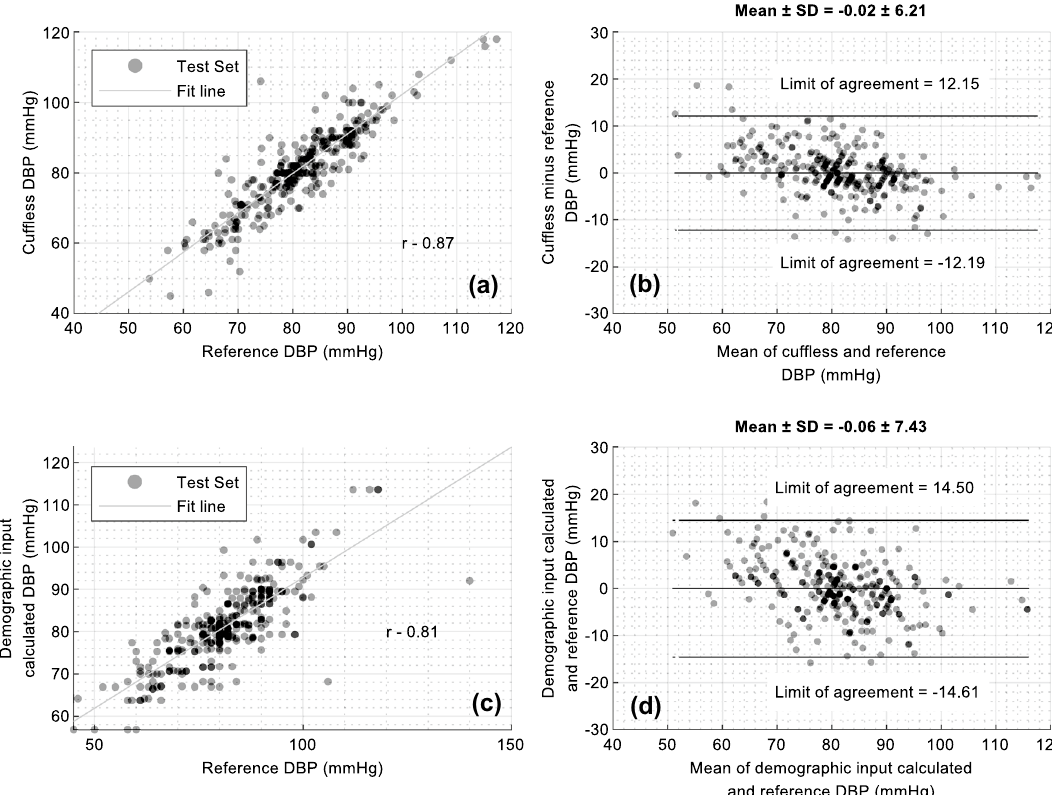
Figure 8. Comparison of actual and predicted measures of Diastolic blood pressures from the SimpleSense-BP cuffless model and a baseline model that uses only demographics data. ( a ) scatter plot of predicted vs actual SBP for test set only for SimpleSense-BP device with the correlation coefficient ( b ) Bland Altman plot for test set with limits of agreement and the mean and standard deviation of errors compared to the reference measurement ( c ) scatter plot of predicted vs actual SBP on test set only for baseline model ( d ) Bland Altman plot on test set only with limits of agreement and the mean and standard deviation of errors compared to the reference measurement for the baseline model.